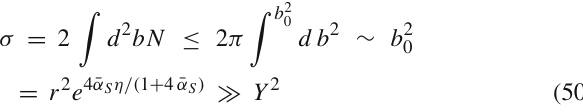
N (cid:9) 1 for ξ ≥ 4 ¯ α S Y /( 1 + 4 ¯ α S ) . Choosing ξ 0 = ln ( b 2